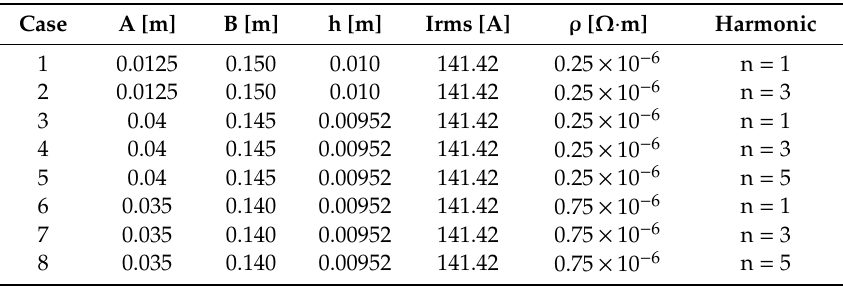
Table 1. Transformer tank wall parameters and frequencies ( µ r = 200 ).